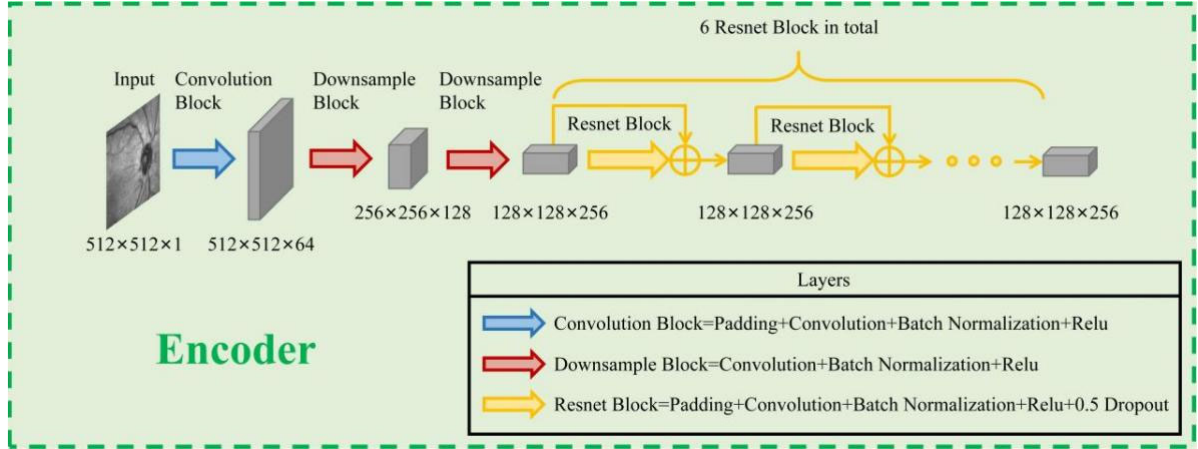
Figure 3. Network architecture of our encoder.